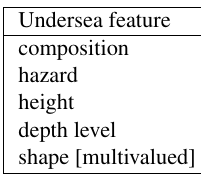
Figure 4: The undersea feature